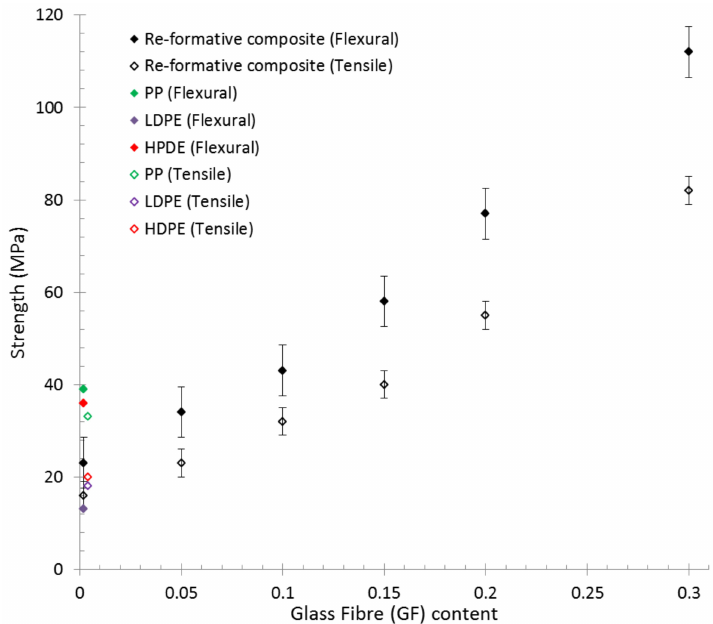
Figure 4. Graph illustrating the flexural strength and tensile strength of the polymer composite when reinforced with varying volume fractions of glass fibre (this